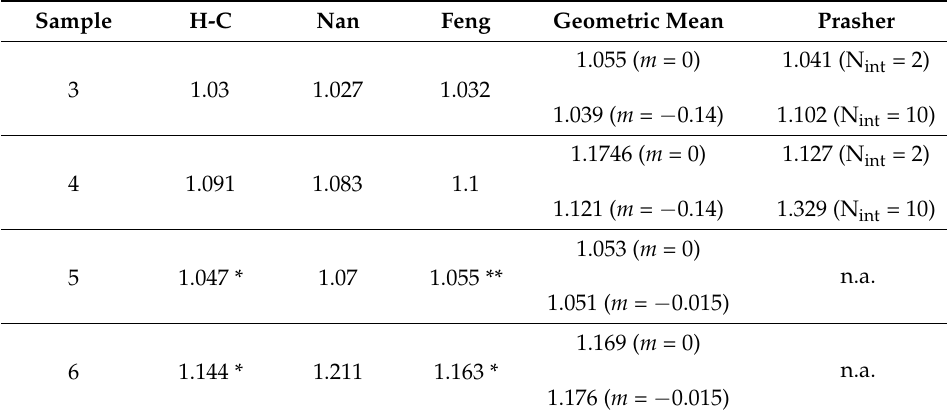
Table 5. Increases in thermal conductivity k / k fb predicted by the models.